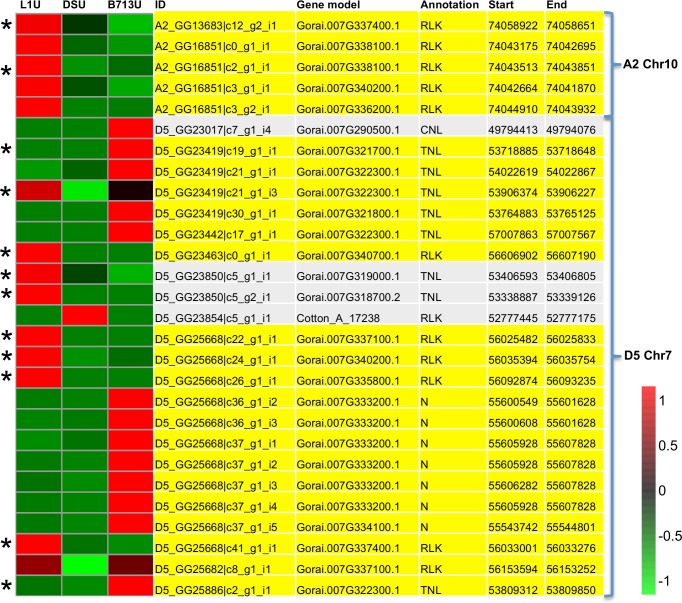
Expression of R. reniformis resistance-associated SSRs-adjacent R-gene annotated transcripts among the susceptible, hypersensitive, and resistant cotton genotypes.The expression of R-gene annotated transcripts that are within 1 megabase of R. reniformis resistance-associated SSR markers is shown. All but one transcript shows statistically significant higher expression in LONREN-1 (L1U) and/or BARBREN-713 (B713U) uninfested treatments than in susceptible genotype (DSU). Transcripts within 1 megabase of BNL3279 are highlighted in yellow, and transcripts that are also differentially expressed (Fold change value > 2 & FDR P-value < 0.01) in response to R. reniformis are denoted with asterisk. The colors represent the relative expression levels of each sequence in the three libraries examined, red indicates higher expression values, and green indicates lower expression values. RLK: leucine-rich repeat receptor kinase; TNL: TIR-NBS-LRR class disease resistance protein; CNL: CC-NBS-LRR class disease resistance protein; N: NB-ARC domain-containing resistance protein; A2: genome of G. arboreum; D5: genome of G. raimondii.